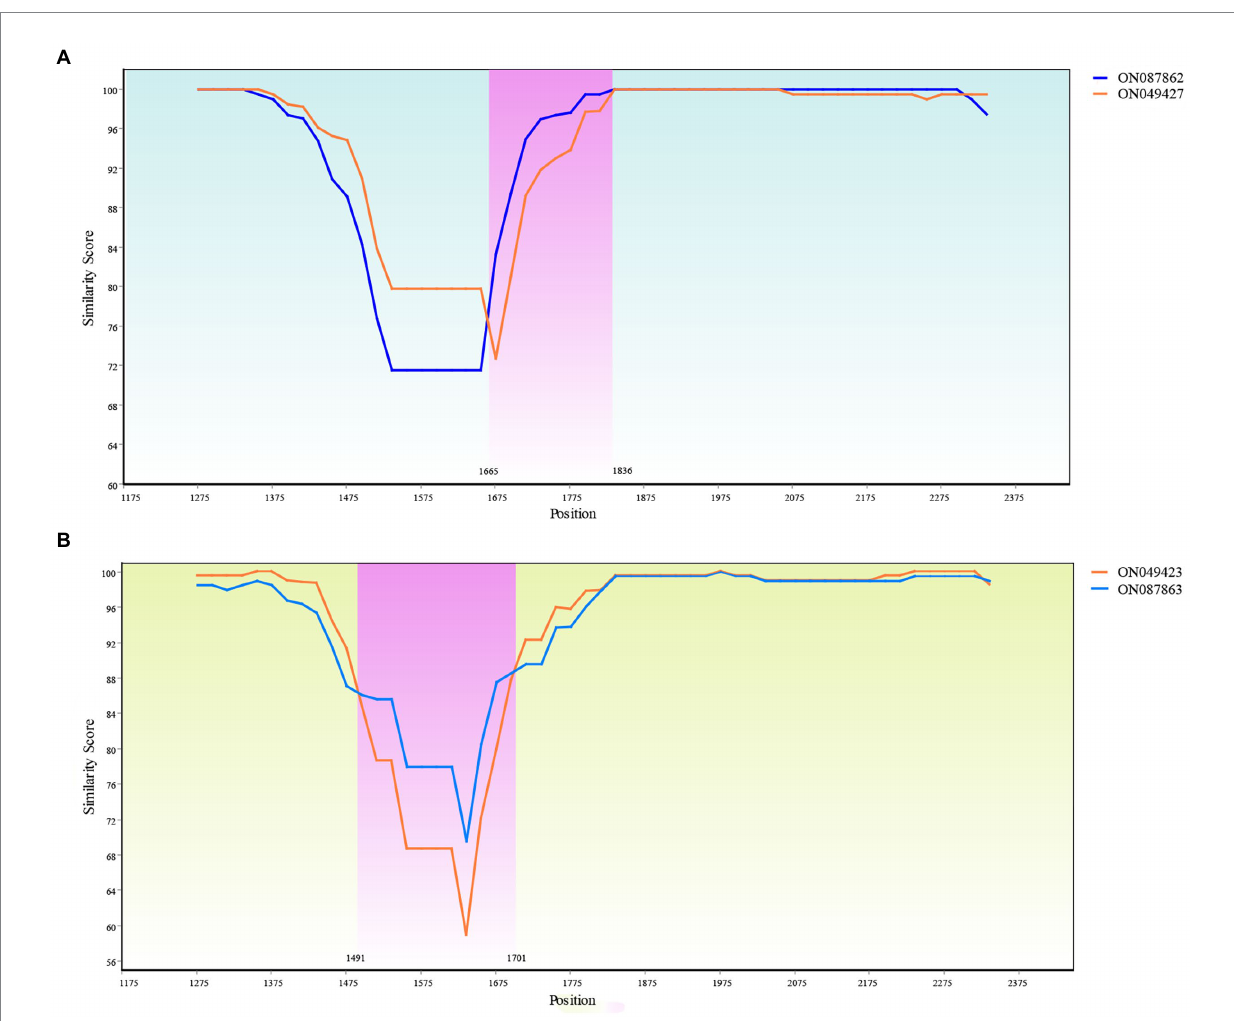
FIGURE 10 Recombination analysis of the ON045425 and ON087858. (A) Recombination of the ON045425. The recombinant main breakpoints were located at 1665 bp and 1836 bp. (B) Recombination of the ON087858. The recombinant main breakpoints were located at 1491 and 1701 bp.